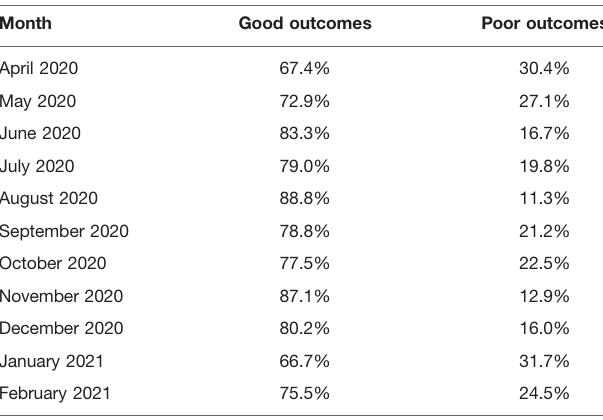
TABLE 4 | Results comparing Outcomes during the COVID-19 Pandemic by month. a Good